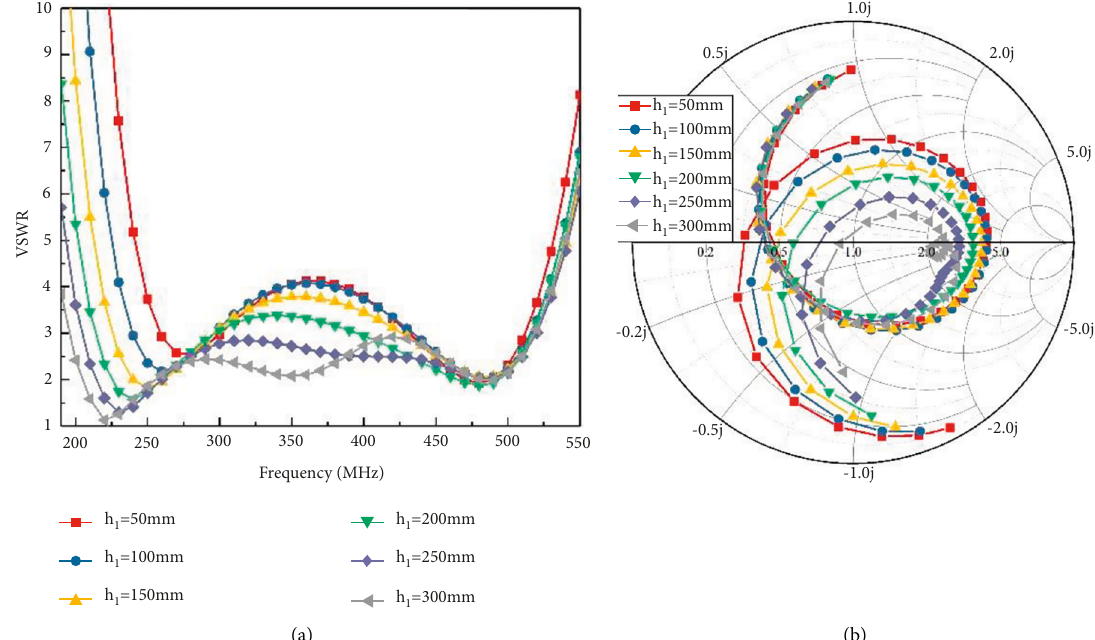
Figure 16: (a) VSWR curves and (b) Smith charts with different values of h